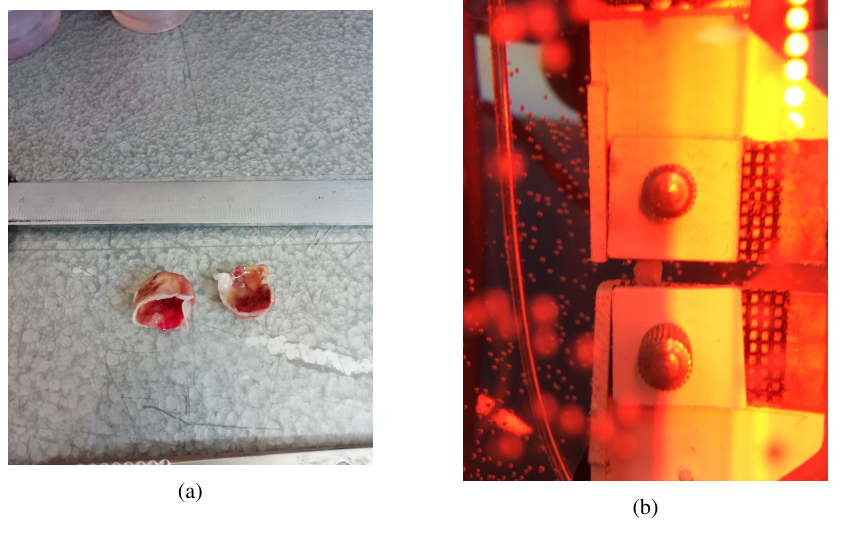
Figure 1: (a) – preparation of the specimens, (b) – specimen in the tensile machine.